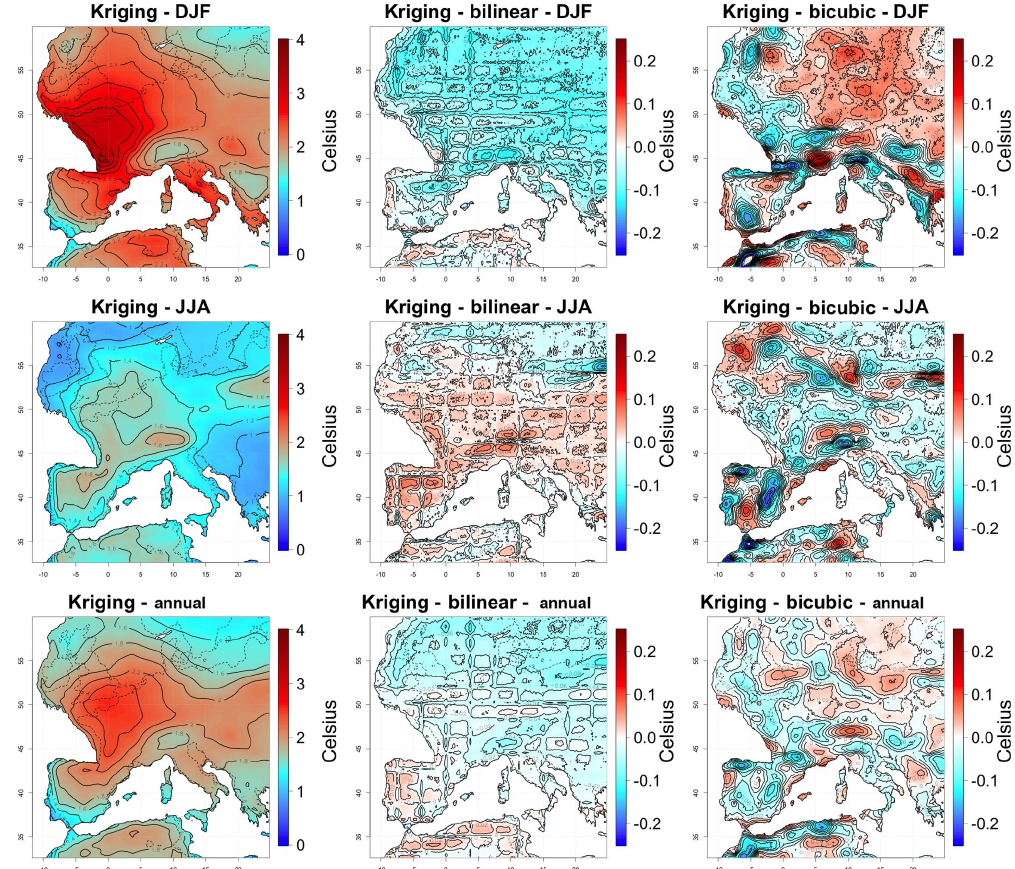
Figure 9. Maps of temporal variations (standard deviation of each month across 50 years) of downscaled monthly mean temperatures over western Europe during the LGM averaged over winter (December, January, February), summer (June, July, August) and the whole year for the kriging interpolation technique, and difference between the kriging and the other two techniques. Variability was computed for each month independently, but results are combined into seasons to summarise the